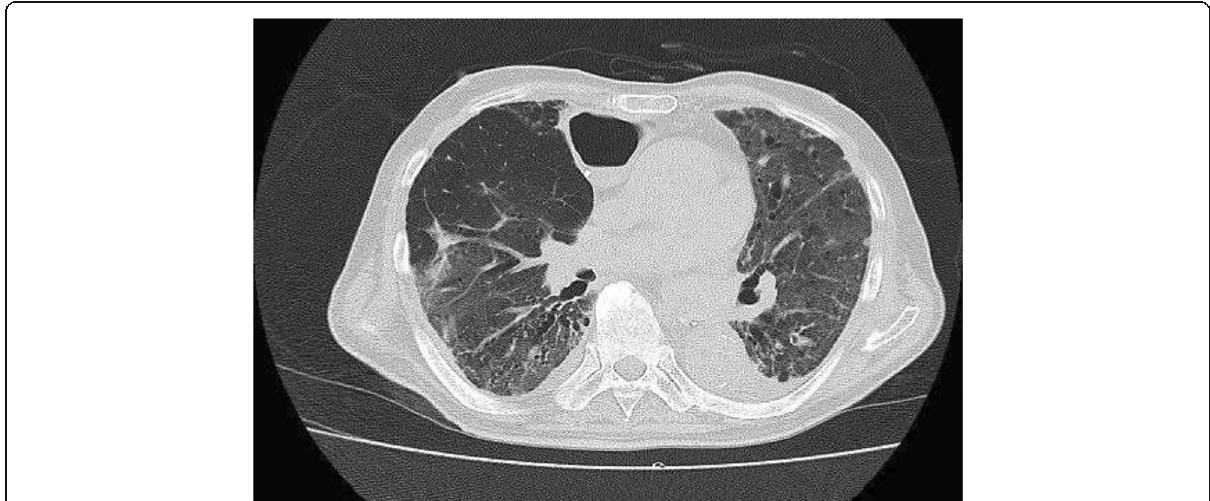
Fig. 3 Computed tomography image showing bilateral pulmonary